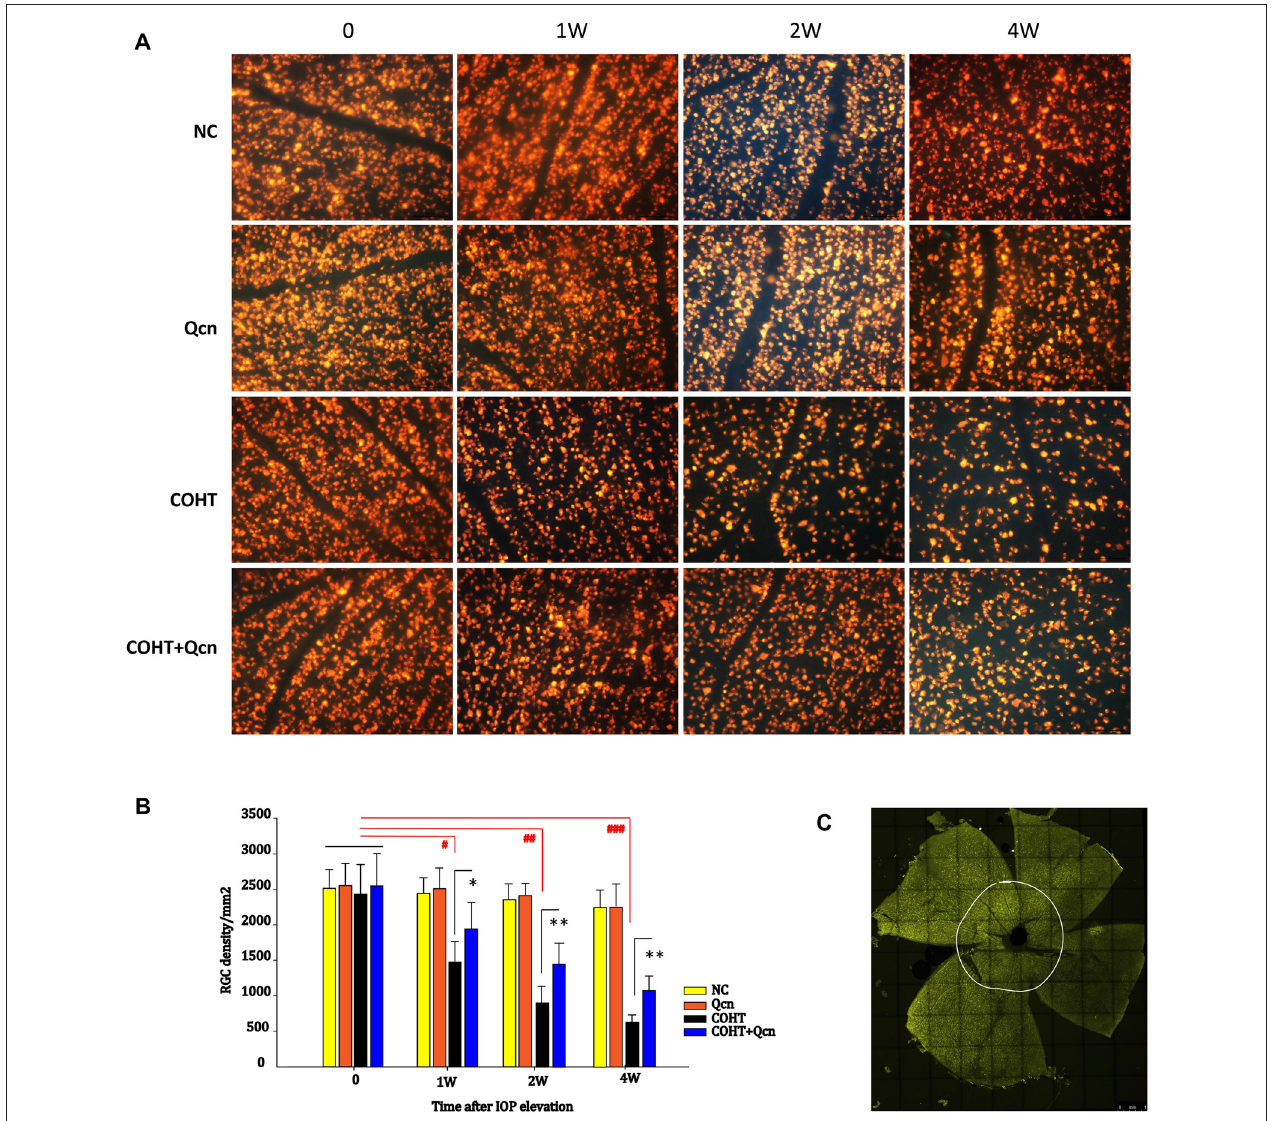
FIGURE 3 | FluoroGold (FG) labeling of surviving retinal ganglion cells (RGCs) in flat-mounted retinas in the NC, Qcn, COHT and COHT+Qcn groups after 0, 1, 2 and 4 weeks of microbead injection. All images were captured at same magnification. Scale bar, 100 µ m (A) . (B) Quantification of FG-labeled RGCs. The data are given as the mean ± SD; # p < 0.05, ## p < 0.01 and ### p < 0.001 and ∗ p < 0.05, ∗∗ p < 0.01. (C) Whole flat-mounted retina. The point on the white circle shows the central position selected for the RGC